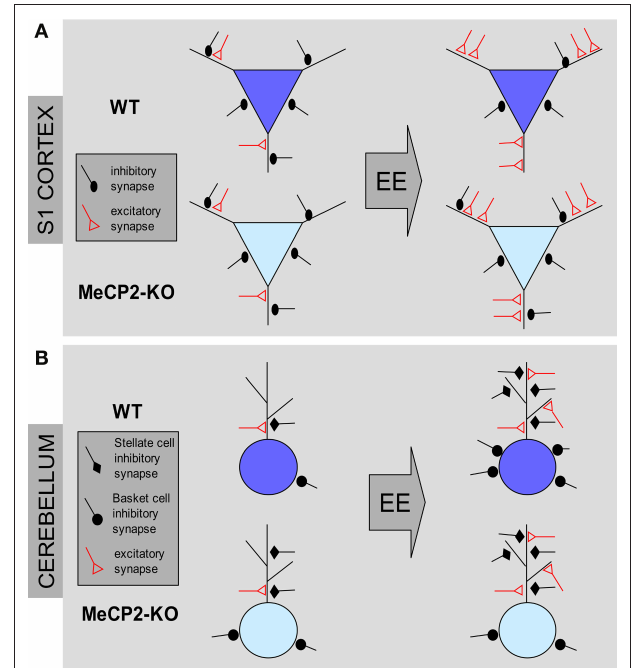
FiGure 2 | Structural effects of environmental enrichment on synaptic circuits of MeCP2 mutant mice. (A) MeCP2-KO and WT mice reared in standard conditions (ST) show similar excitatory and inhibitory synaptic density in the S1 cortex. Environmental enrichment (EE) leads to an increase of excitatory synapses and a loss of inhibitory synapses in WT male animals (blue pyramidal neurons). In KO male mice, EE produces an increase of excitatory contacts but no changes of inhibitory synapse density (cyan pyramidal neurons). (B) ST-MeCP2-KO mice show an increased number of inhibitory synapses on the soma and dendrites of Purkinje cells (PC) in the cerebellum compared to ST–WT. EE induce an increase of excitatory contacts in both genotypes. However, while EE increases the density of inhibitory synapses on both dendrites and soma in WT animals, it is able to increase only the density of inhibitory synapses on dendrites MeCP2-KO mice with no effect on inhibitory synapse density on the PC